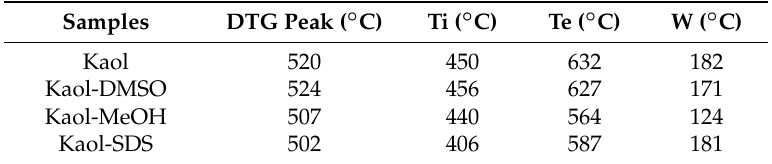
Figure 3. TG /DTG curves of Kaol, Kaol-DMSO, Kaol-MeOH and Kaol-SDS. Table 2. The corresponding parameters of the dehydroxylation of Kaol and its intercalation compounds.